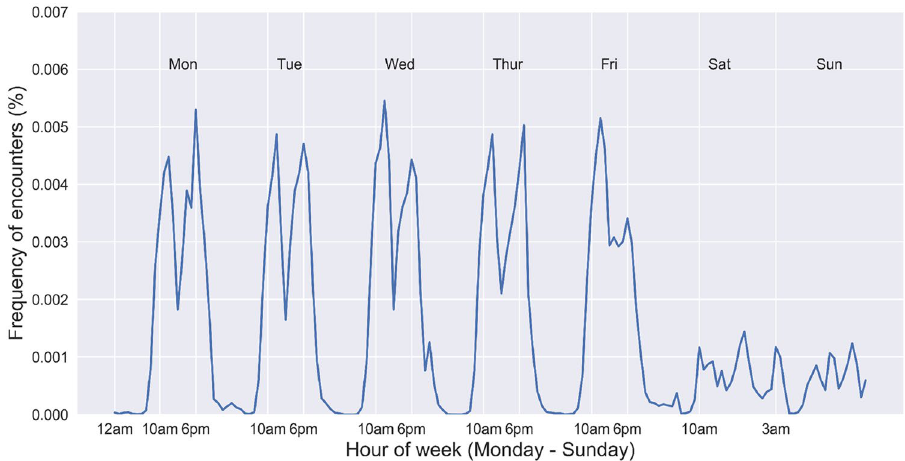
Figure 1. Temporal distribution of physical encounters. The x-axis corresponds to the hour within the week, and the corresponding day of the week is labeled on top of the figure. The y-axis is the frequencies. We only show one week of activity here to emphasize detail in patterns, but similar patterns are visible for all weeks of the